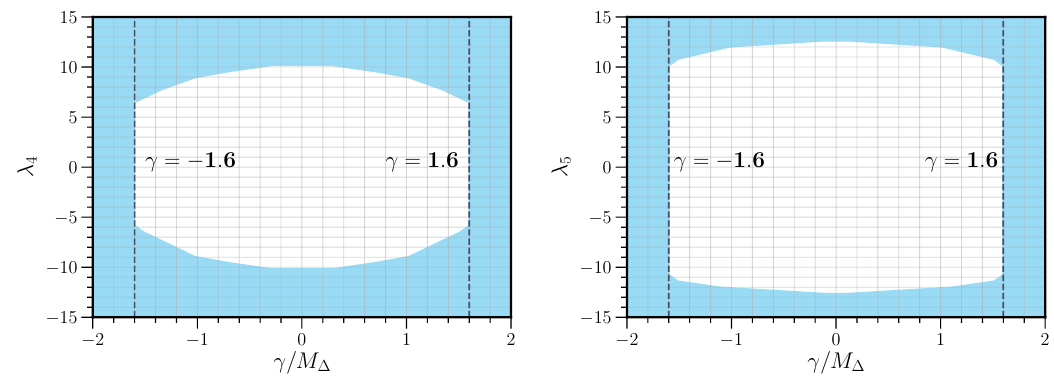
Figure 11 . Unitarity bounds on the ratio γ/M ∆ against λ 4 and λ 5 , including finite scattering